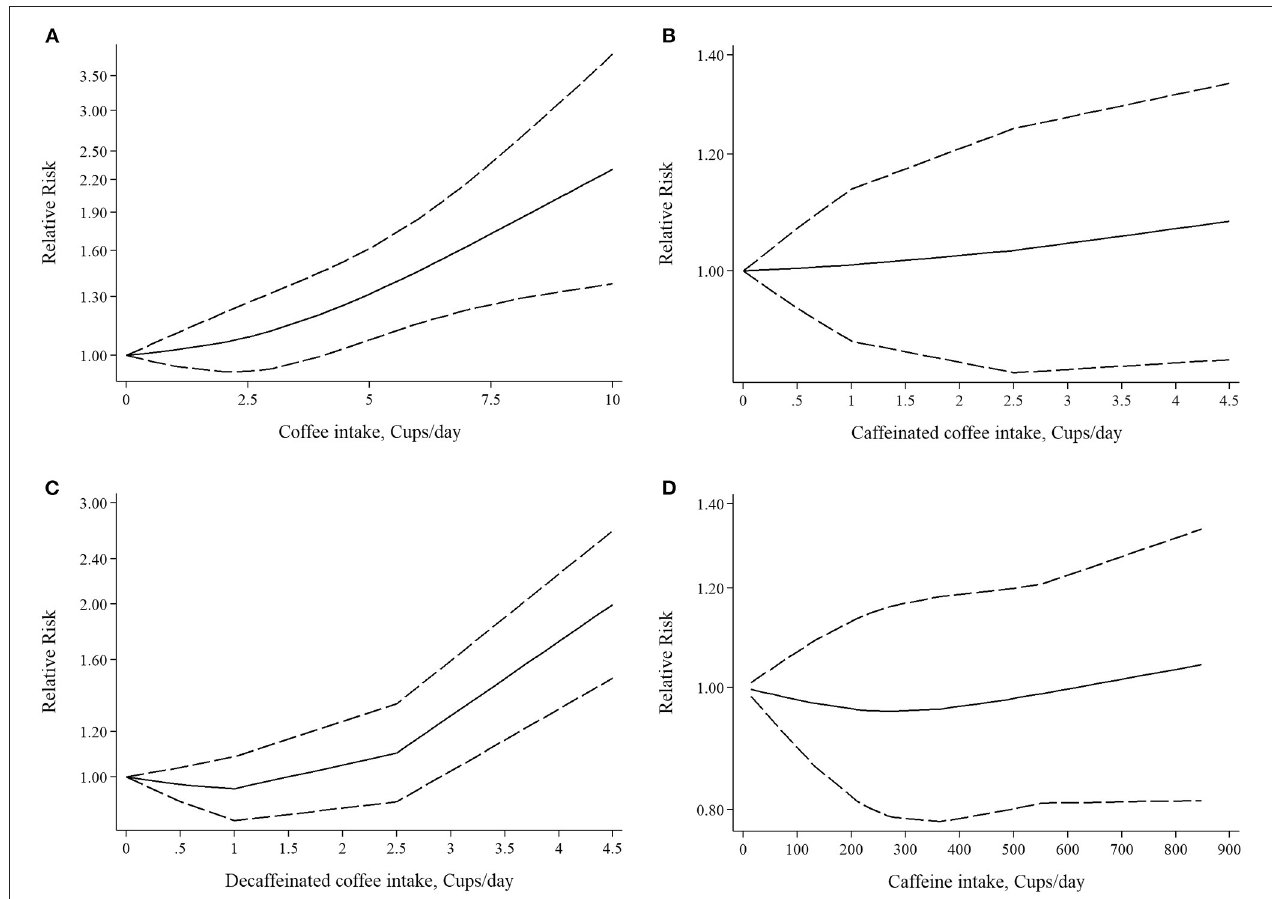
FIGURE 5 | Forest plots showing relative risks of developing rheumatoid arthritis for (A) highest vs. lowest categories of tea intake and (B) linear dose-response association for each one cup/day increase of tea intake.